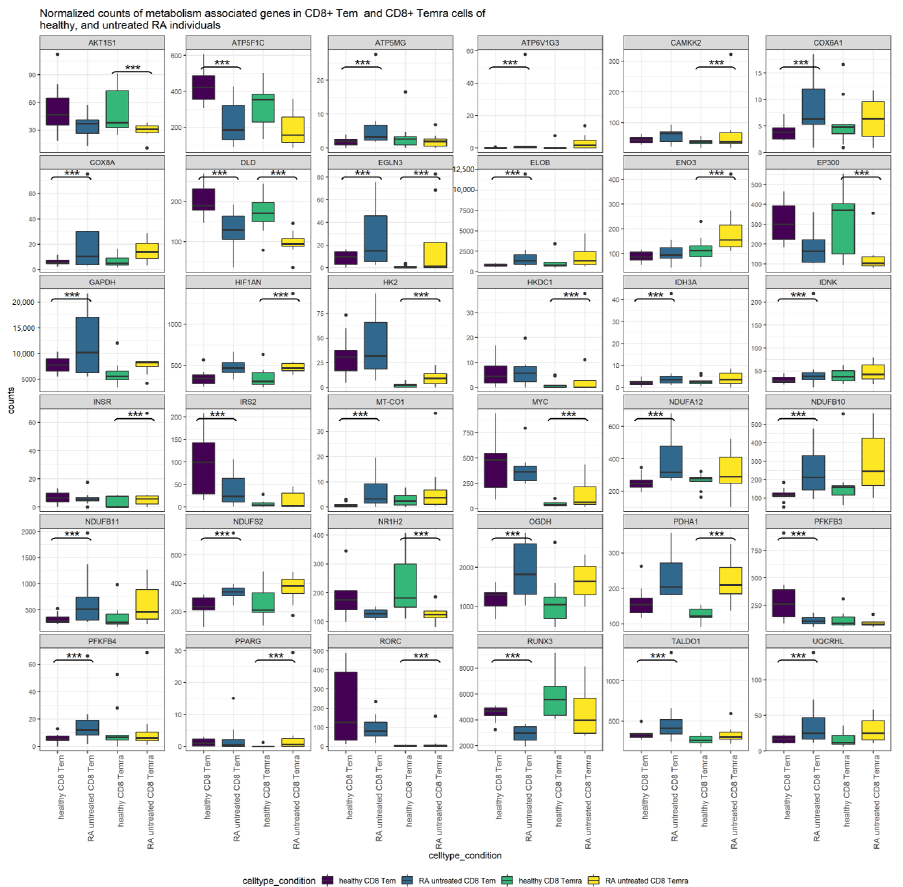
Figure 11. Normalized counts of genes associated with metabolic pathways or the regulation of glycolysis that show differential regulation in untreated RA CD8 + Tem cells or in untreated RA CD8 + Temra cells. Significant differential regulation is shown by asterisks